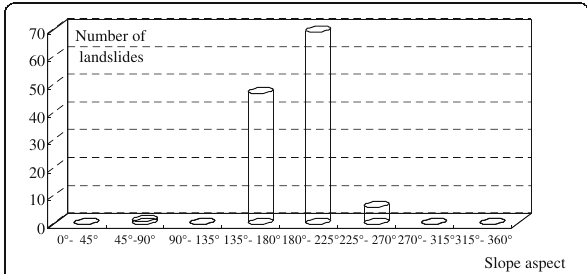
Fig. 17 Relationships between slope aspect and landslide